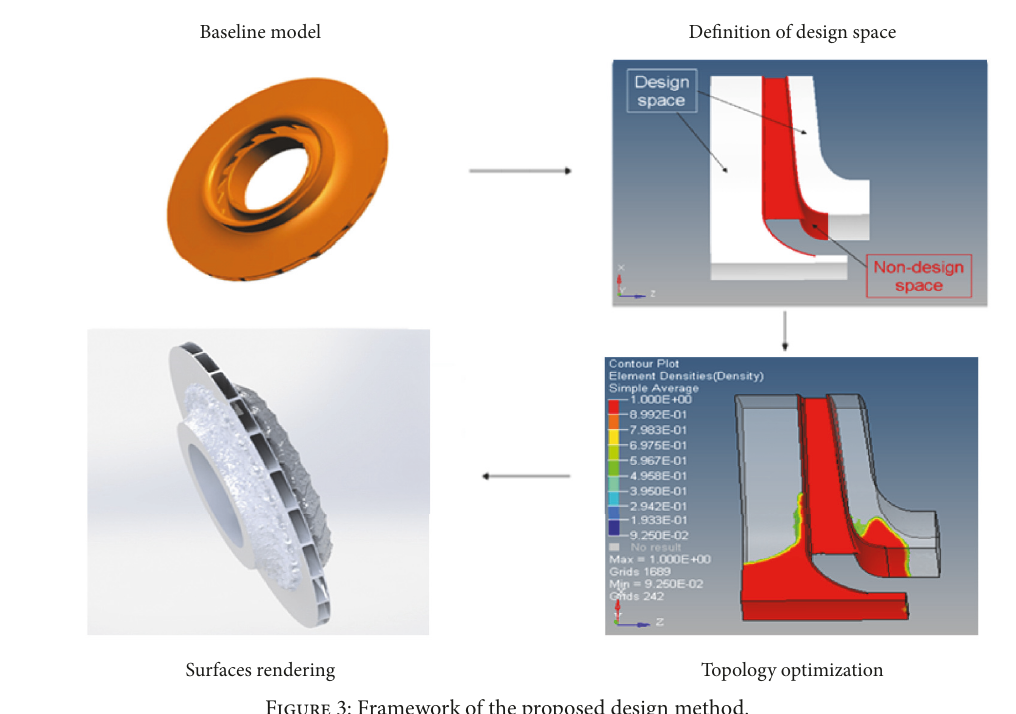
Figure 3: Framework of the proposed design method.